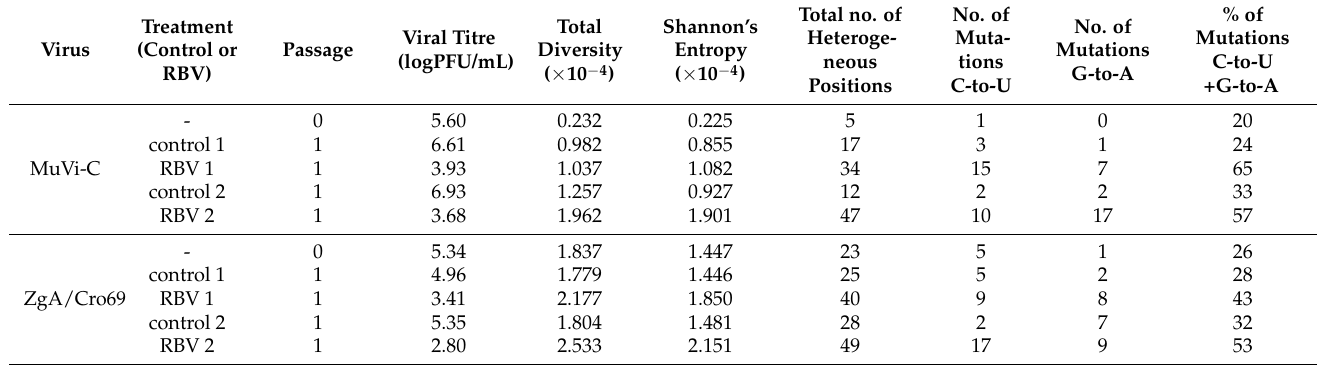
“-” in the Treatment column stands for parental virus; and 1 or 2 stands for independent experiments.